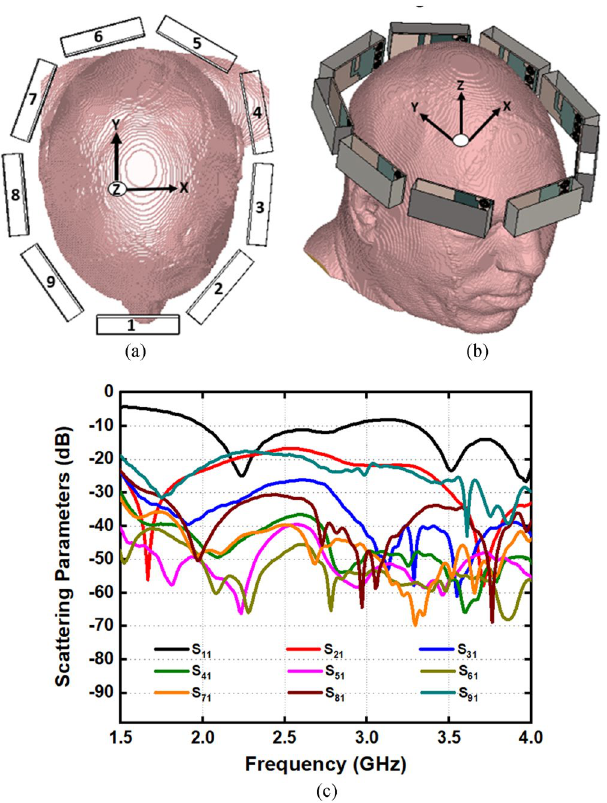
Figure 9. ( a ) Top view ( b ) perspective view of nine antenna setup and ( c ) antenna scattering parameters with mutual coupling effect.